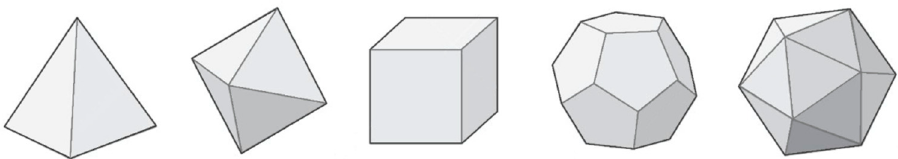
Figure 1. Five Platonic structures: tetrahedron, octahedron, hexahedron (cube), dodecahedron, and icosahedron.